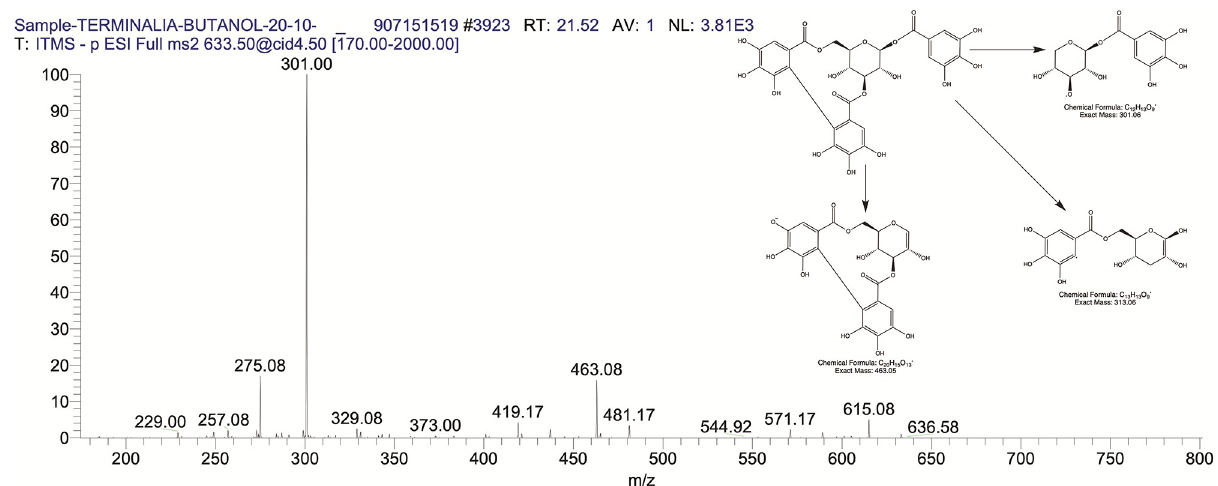
Fig 11. The mass spectrum of corilagin (1-O-galloyl- 3,6-O-HHDP- β - ᴅ -Glc) and its fragmentation pattern.